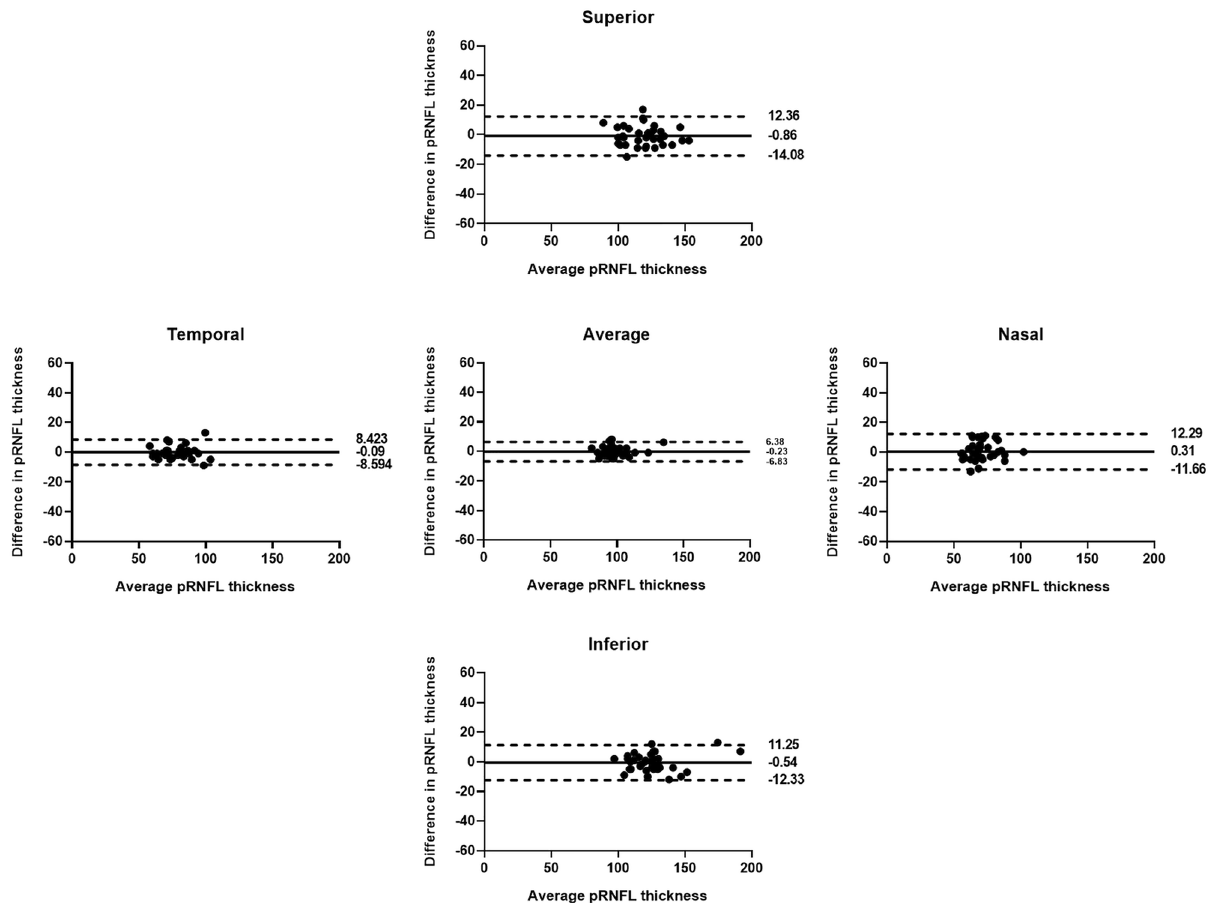
Figure 1. Bland–Altman plots showing the agreement of peripapillary retinal nerve fiber layer (pRNFL) thickness measurements at the two visits in group N. Solid lines represent bias (mean pRNFL thickness difference), and dotted lines represent the upper and lower limits of agreement. Mean bias and upper and lower limits of agreement are shown at the right end of each line. There were no differences in average or sectoral pRNFL thickness measurements between the visits, indicating good